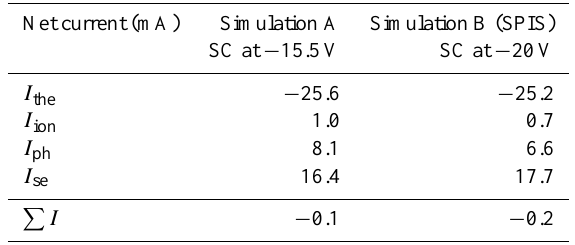
Table 2. Comparison of net currents on spacecraft for